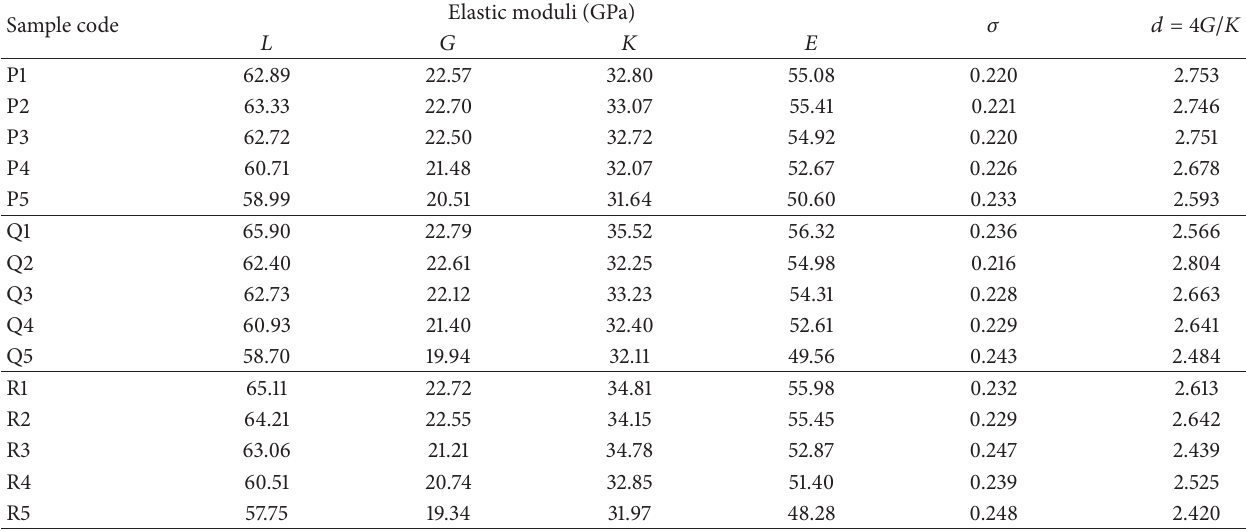
Table 4: Longitudinal ( 𝐿 ), shear ( 𝐺 ), Young’s ( 𝐸 ), and bulk ( 𝐾 ) modulus, Poisson’s ratio ( 𝜎 ), and fractal bond connectivity ( 𝑑 ) for ZOFT glass